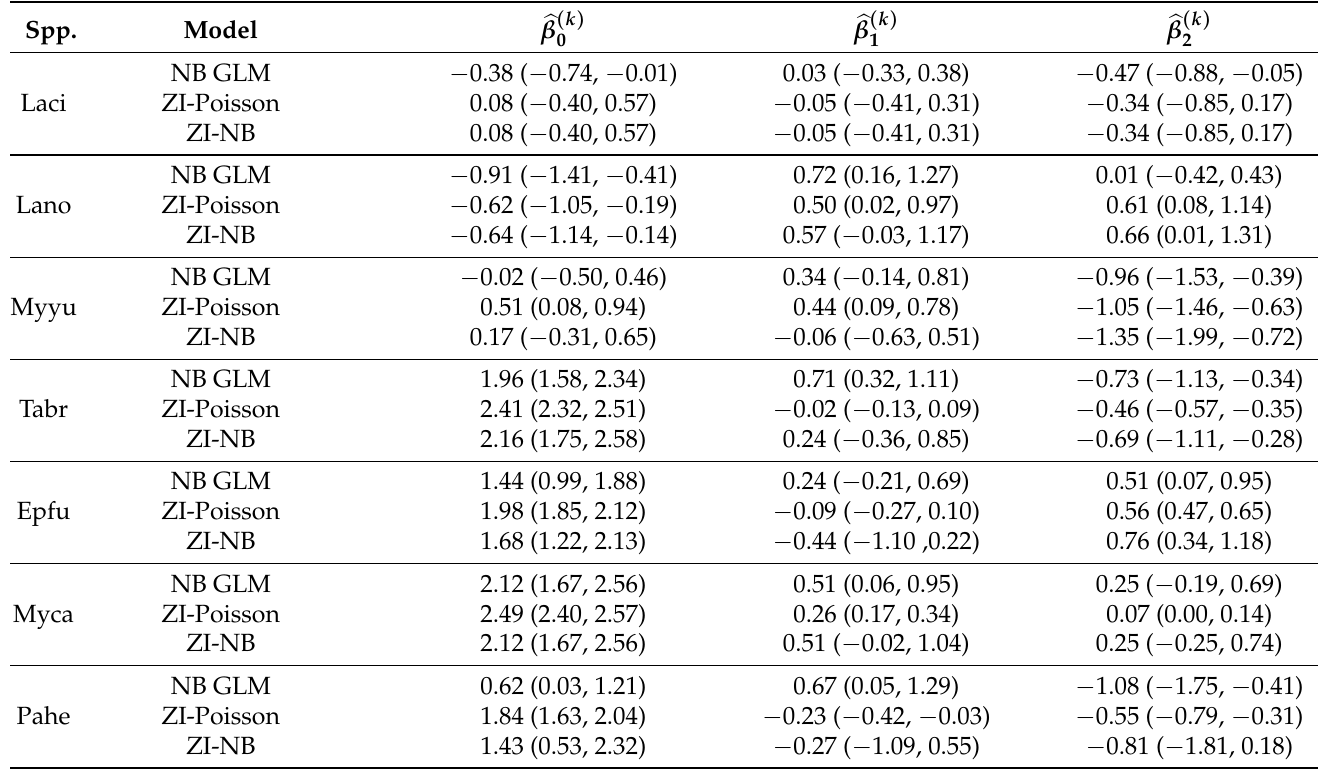
Table 2. Parameter estimates with either 95% confidence or credible intervals when fitting a negative binomial (NB GLM), zero-inflated Poisson (ZI-Poisson), and zero-inflated NB (ZI-NB) model to each species (spp.) in the bat acoustic count data. Seven bat species were recorded in oak woodlands of California, labelled by the following abbreviations: Tadarida brasiliensis (Tabr), Eptesicus fuscus (Epfu), Lasionycteris noctivagans (Lano), Lasiurus cinereus (Laci), Parastrellus hesperus (Pahe), Myotis yumanensis (Myyu), and Myotis californicus